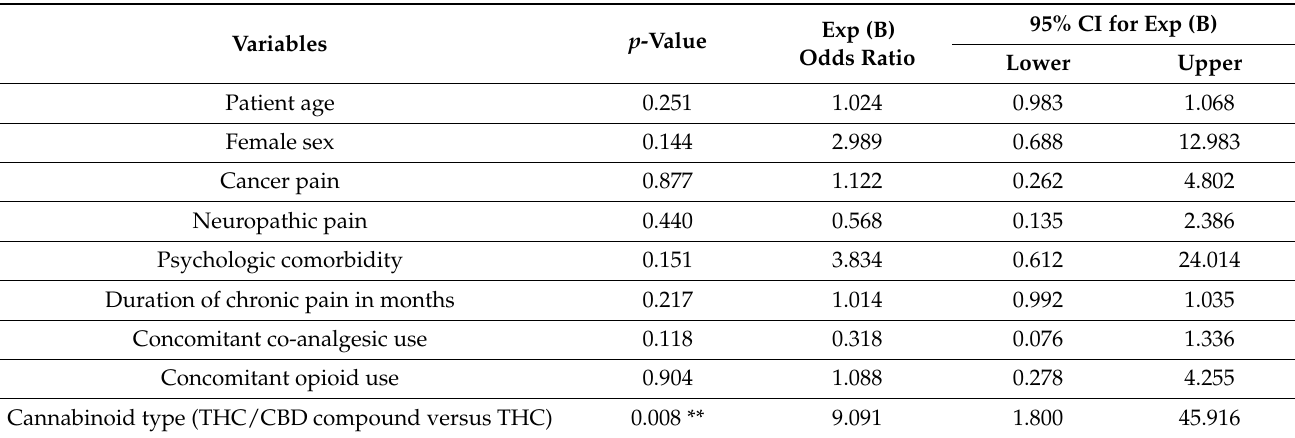
Table 4. Multivariate regression analysis of the association between at least a 30% improvement in pain-associated disability and different variables under treatment with cannabinoids.